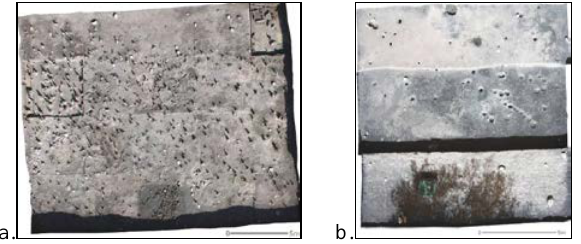
Figure 21. Orthorectified image of a. trench A, b. trench